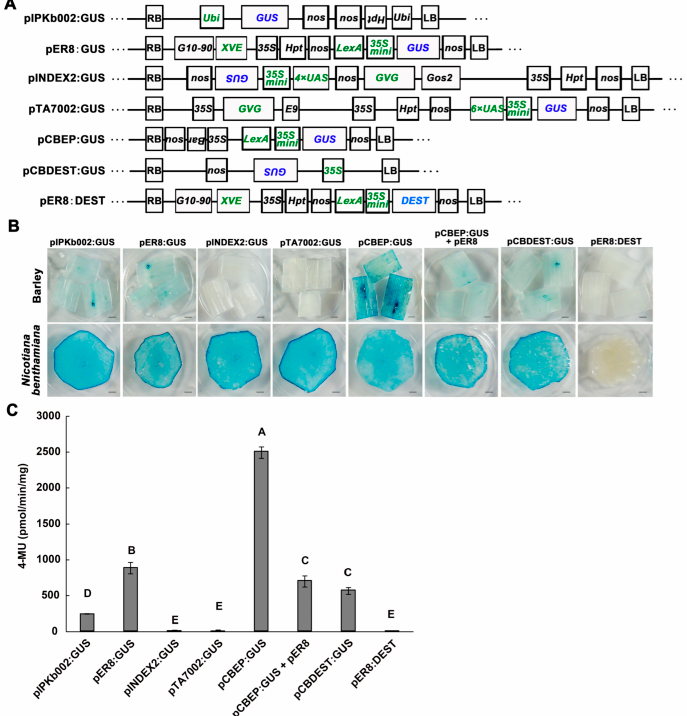
Figure 1. Comparison of transient expression efficiency between different vectors in barley (var. E9) leaves. ( A ). Schematic drawings of binary vectors used in this report. Diverse cis-regulatory elements and promoters in T-DNA were selected for GUS ( β -glucuronidase) expression. The empty vector pER8:DEST was used as a negative control. Green letters represent different promoter elements regulating GUS transcription: 35S indicates cauliflower mosaic virus (CaMV) 35S promoter; Ubi indicates ubiquitin promoter; XVE , an estradiol-activated chimeric transcription activator, controlled by constitutive promoter G10–90 and targets the LexA operator ( LexA ); 35S mini indicates − 46 to +1 region of the 35S minimal promoter; GVG , a dexamethasone (DEX) activated chimeric transcription activator, target UAS operator; 4×UAS and 6×UAS indicate four or six copies of GAL4 UAS; Gos2 indicates the constitutive promoter of rice GOS2 gene; nos indicates terminator; Hpt and Bar indicate Hygromycin and Basta resistance genes, respectively; RB and LB indicate T-DNA right and left border regions; inverted letters represent the gene orientation (from right to left). ( B ). GUS staining after transient expression with different vectors in barley ( upper ) and Nicotiana benthamiana ( lower ) leaves. AGL1 and individual vectors (0.5 OD 600 ) were syringe infiltrated into the first